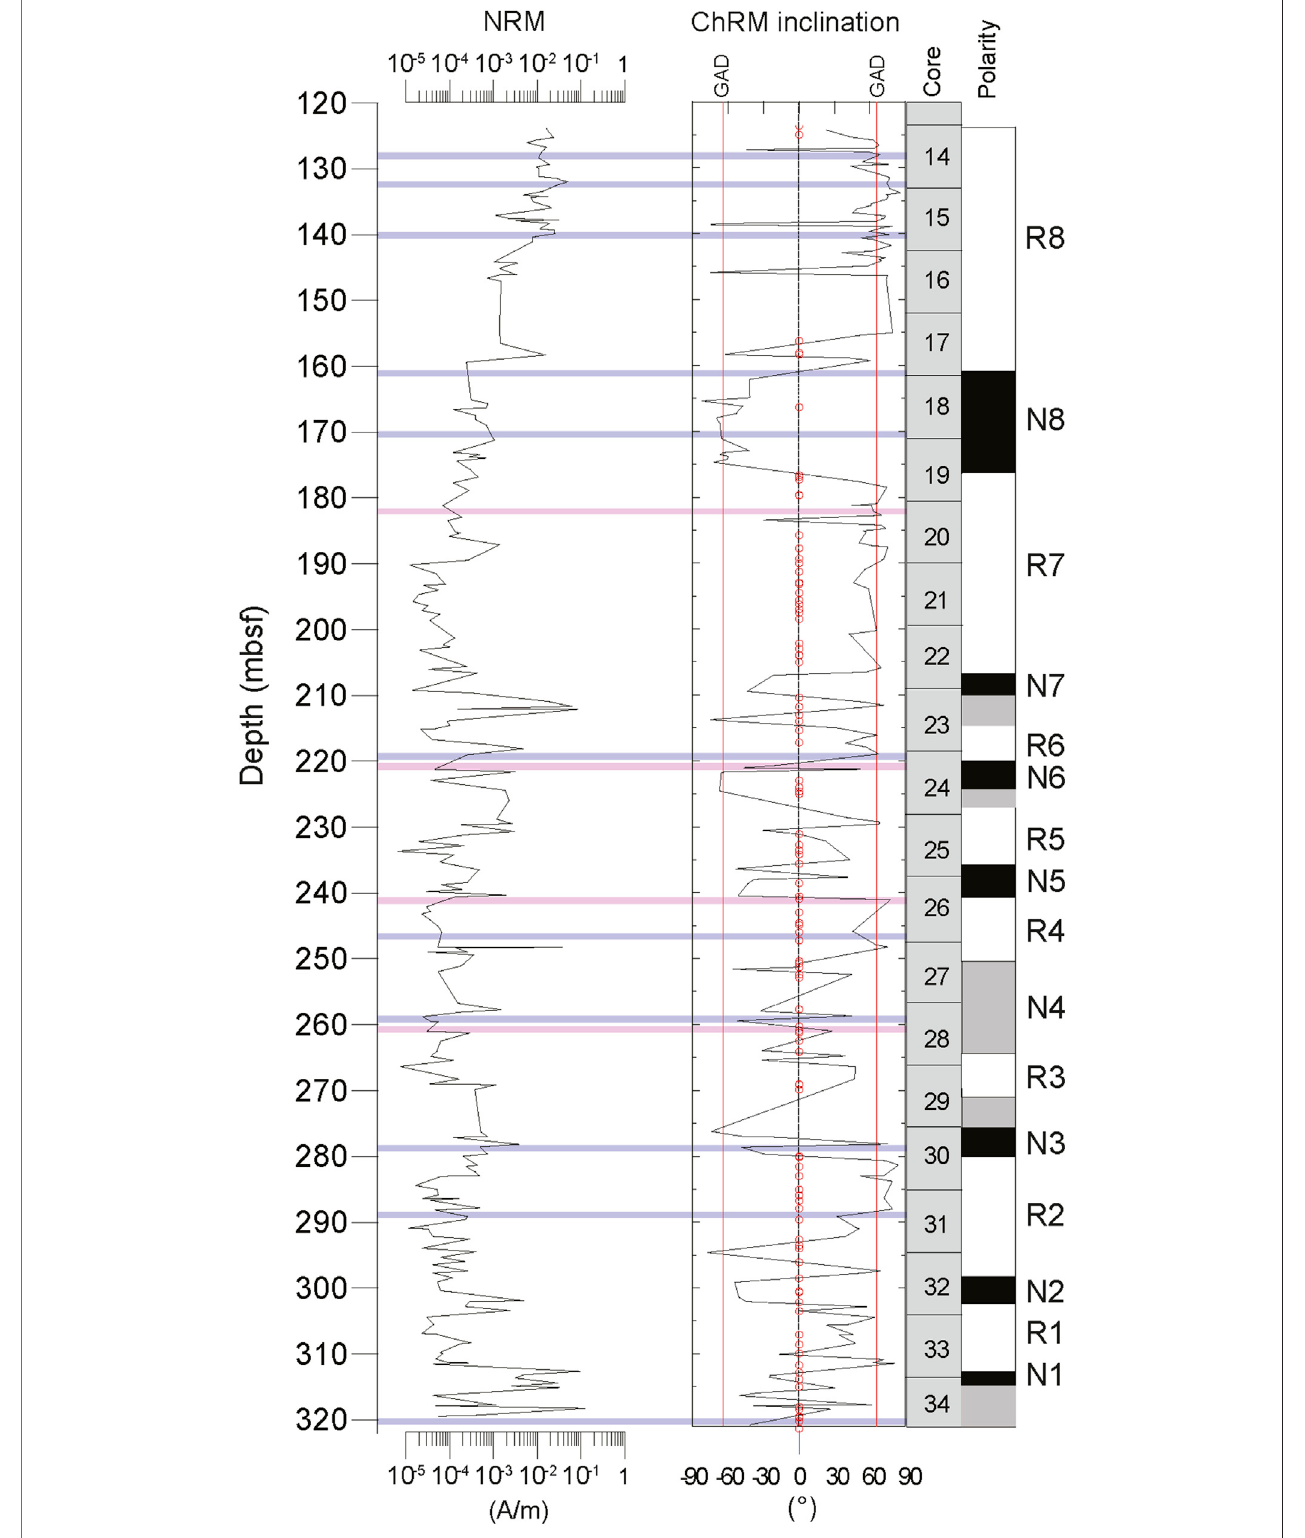
FIGURE 6 | Downcore variations of NRM intensity, ChRM inclination, and magnetic polarity zonation (black denotes normal polarity and white denotes reversed polarity).